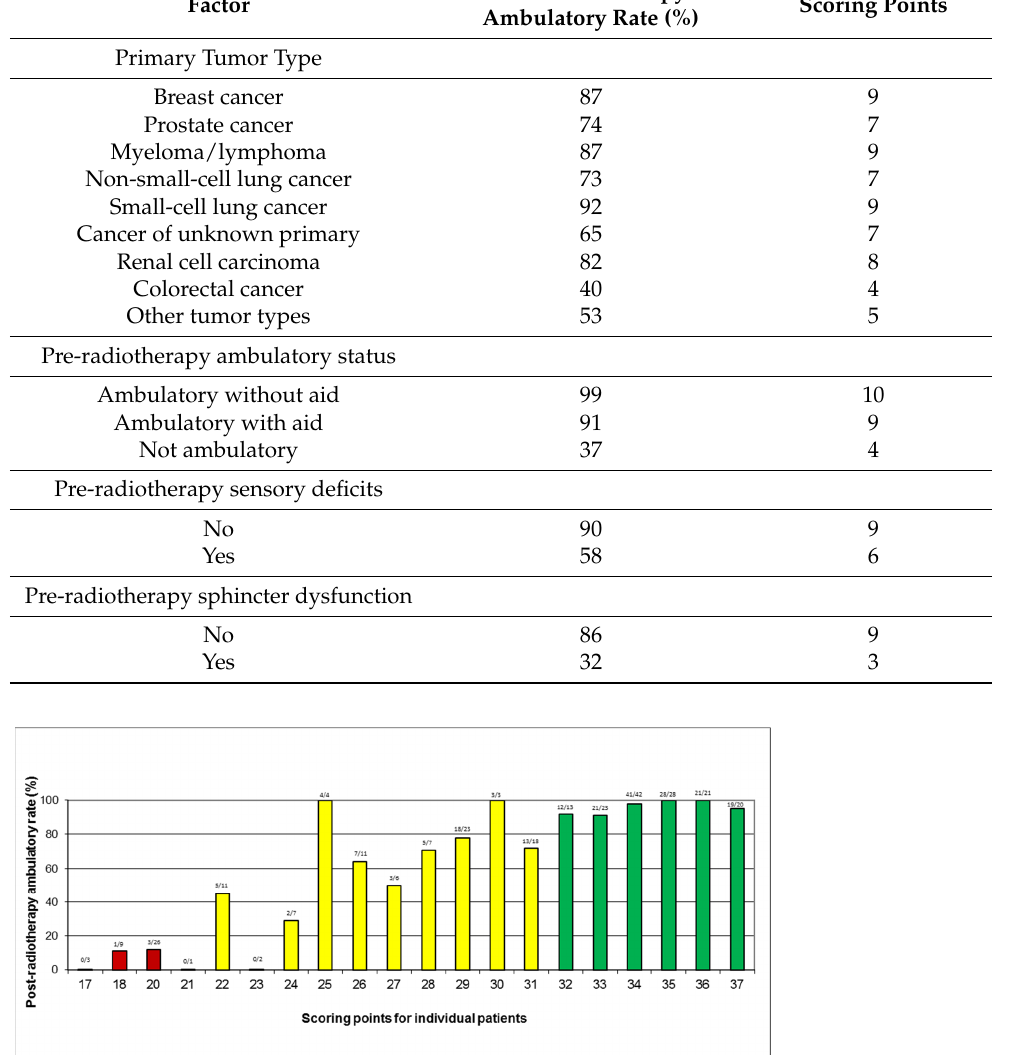
Figure 1. Scoring points for individual patients and post-radiotherapy ambulatory rates (in %). Colours represent the prognostic groups, i.e., red = least favorable group, yellow = intermediate group, and green = most favorable group.